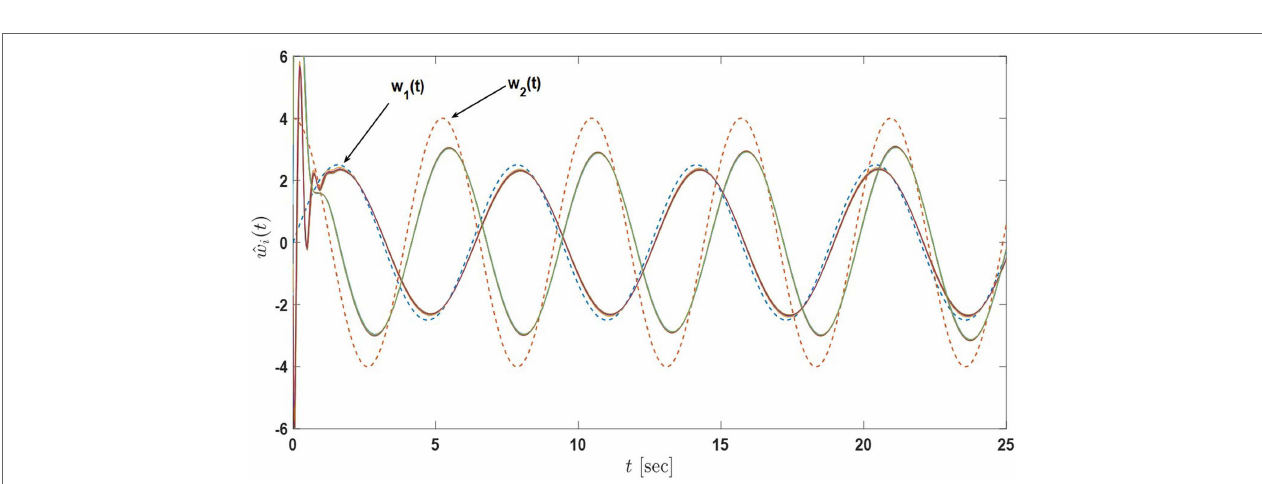
FIGURE 6 | State estimates of the sensor network in Example 2 with 8 active nodes and 4 passive nodes under the proposed architecture equations (7) and (8) (the dash lines denote the states of the actual process and the solid lines denote the state estimates of nodes) Tran et al. (2017).